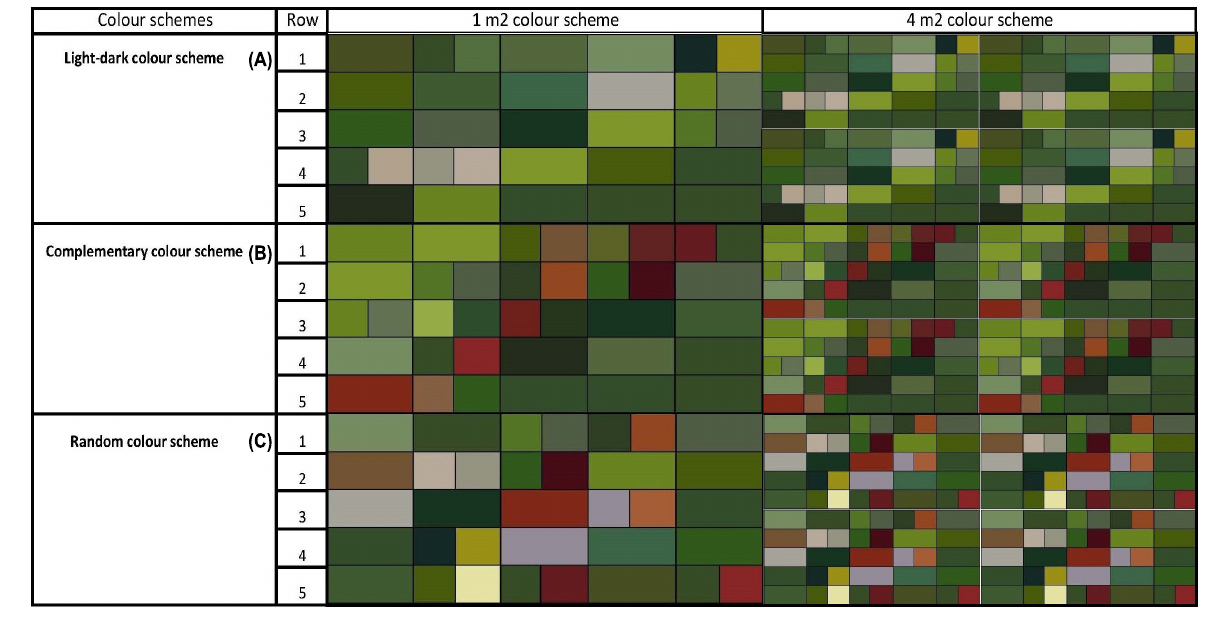
Frontiers in Ecology and Evolution |